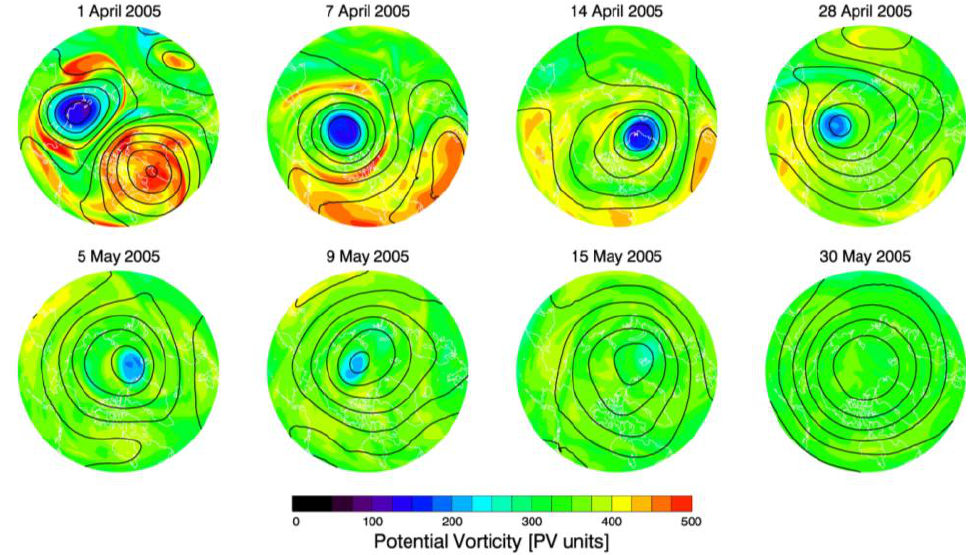
1 Fig. 8. Ertel potential vorticity at 850 K potential temperature from 50–90 ◦ N for 1, 7, 14, and 28 April and 5, 9, 15, and 30 May 2005. Red Figure 8. Ertel potential vorticity at 850 K potential temperature from 50–90°N for 1, 7, 14, 2 (blue) indicates high (low) PV values. Black lines indicate 10hPa geopotential height at 100-m contour intervals. and 28 April and 5, 9, 15, and 30 May 2005. Red (blue) indicates high (low) PV values. 3 Black lines indicate 10 hPa geopotential height at 100-m contour intervals. 4